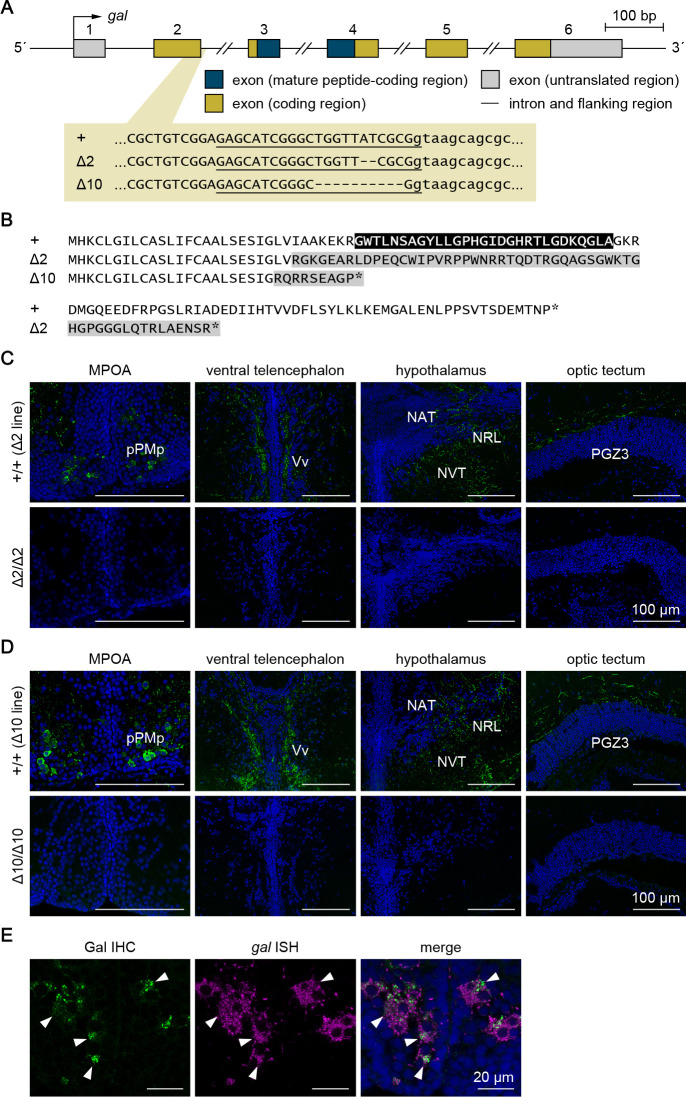
Generation and verification of gal knockout medaka.Two different lines of gal knockout medaka (Δ2 and Δ10) were generated by CRISPR/Cas9-mediated genome editing. (A) Gene structure of gal showing the location of the CRISPR target site, which is enlarged to show the nucleotide sequences of the wild-type (+) and targeted (Δ2 and Δ10) alleles. Exon numbers are indicated above each exon. Exon and intron sequences are given in uppercase and lowercase letters, respectively. The target sequence complementary to the CRISPR RNA is underlined, and deleted nucleotides are indicated by dashes. (B) Comparison of the deduced Gal precursor protein sequences of the +, Δ2, and Δ10 alleles. The mature Gal polypeptide is indicated in white letters on a black background. The altered sequence caused by a frameshift is shaded in gray. Asterisks indicate stop codons. (C, D) Successful ablation of gal in the Δ2 (C) and Δ10 (D) knockout lines was confirmed by the observation of Gal immunoreactivity (green) in +/+ males but not in Δ2/Δ2 or Δ10/Δ10 males (n = 4 per group). Shown are representative micrographs of the MPOA containing pPMp, where the cell bodies of Gal-expressing neurons reside, and the ventral telencephalon, hypothalamus, and optic tectum, where Gal-containing axons are densely distributed. Blue color indicates nuclear counterstaining. Scale bars represent 100 μm. For abbreviations of brain nuclei, see Supplementary file 1. (E) The specificity of the anti-GAL antibody was verified by a pattern of labeling consistent with gal-expressing neurons detected by in situ hybridization (ISH). Left and middle panels show images of, respectively, immunohistochemistry (IHC) using anti-GAL antibody (green) and ISH detecting gal expression (magenta) in the same pPMp section; right panel shows the merged image with nuclear counterstaining (blue). Arrowheads indicate representative neuronal cell bodies labeled by both IHC and ISH. Scale bars represent 20 μm.